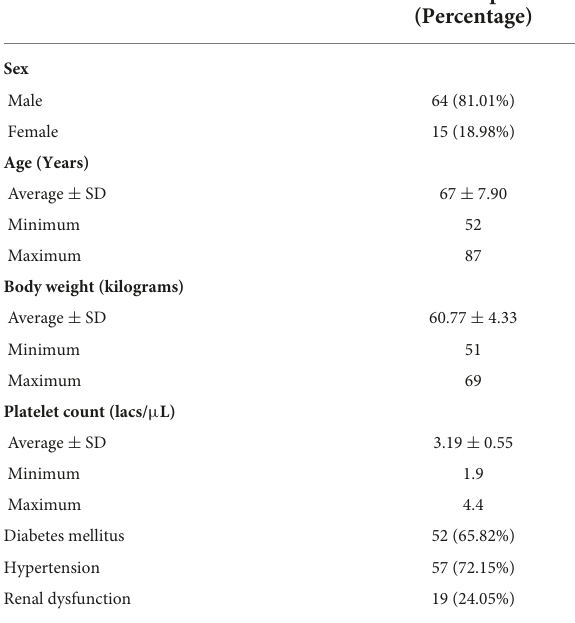
TABLE 2 Comparison of thromboxane B2 levels after 4 and 24 h of acetylsalicylic acid intake.